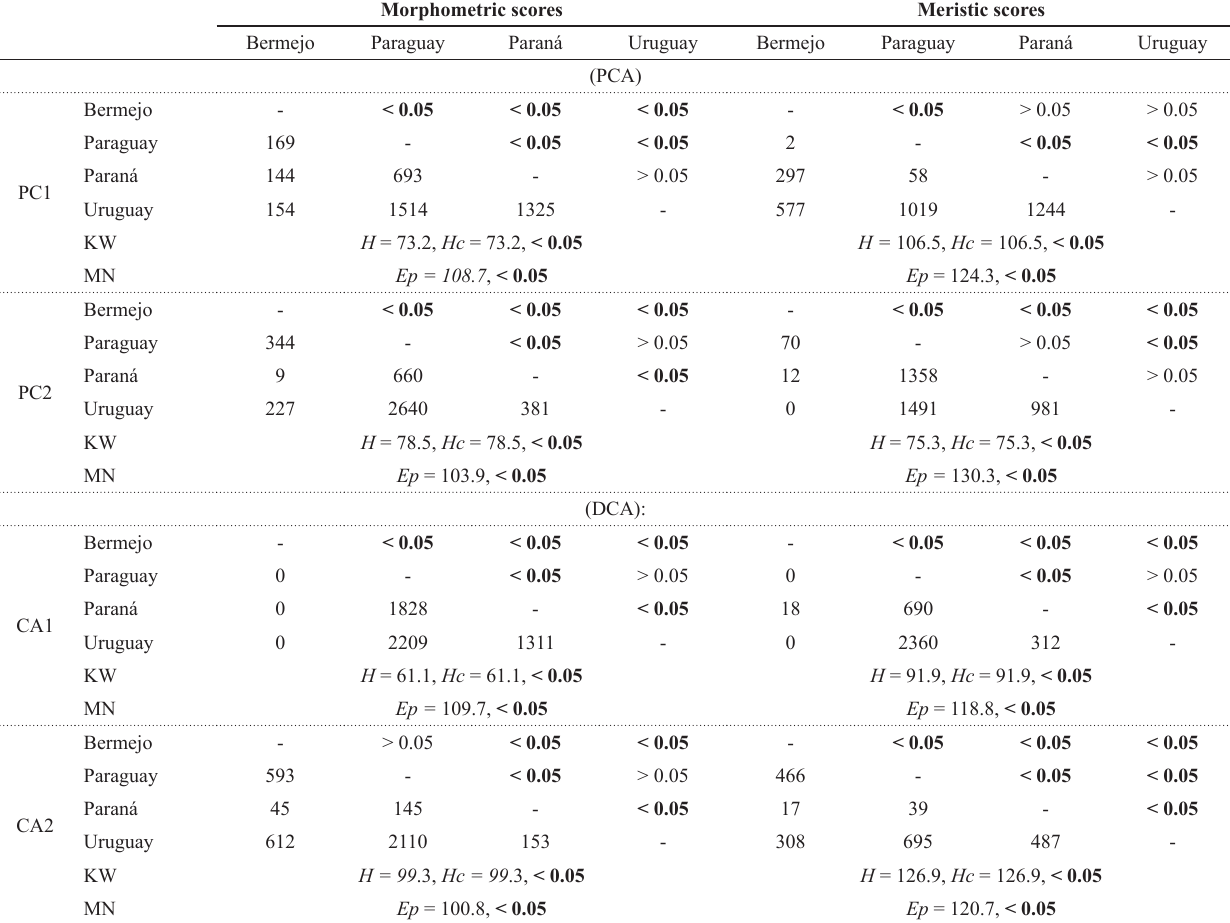
Tab. 4. Results of Kruskall-Wallis (KW) tests and Mann-whitney ( U ) pairwise comparisons (based on the Bonferroni- corrected p values ) of the resultant shape and meristic scores of principal component analysis (PCA) and discriminant canonical analysis (DCA). U values: below diagonal; multivariate normality: MN; p values are expressed as < 0.05 or > 0.05 (significant results in